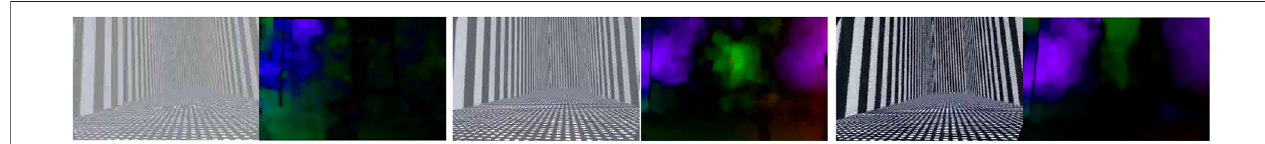
FIGURE 9 | Frames captured in days 2, 3, and 4 of training days along with their corresponding optic fl ow visualization. The frames show the view a typical participant saw traveling through the same spot at the same speed on the three separate days of the experiment, along with their optic fl ow